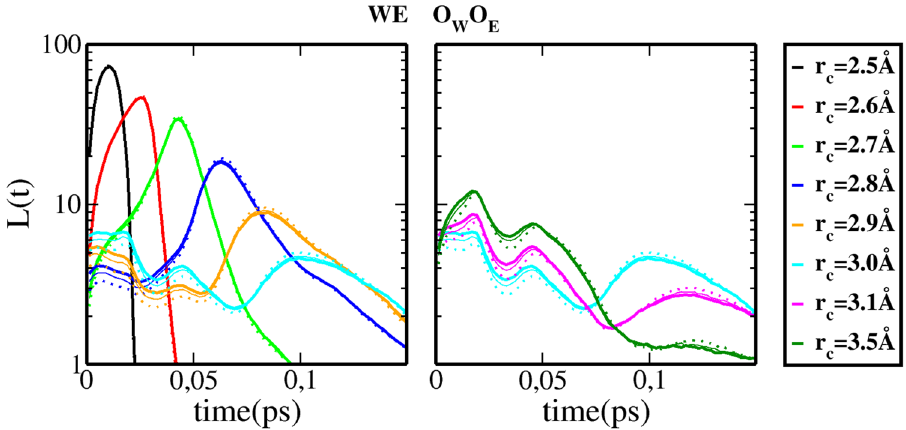
Figure 3. H-bond life time distributions L ( t ) of water–water clusters in water–ethanol (WE) mixtures. The full lines are for ethanol concentration x E = 0.2 , the small dashes for x E = 0.5 and large dashes for x E = 0.8 . Complementary informations in Fig. 1B of the SI